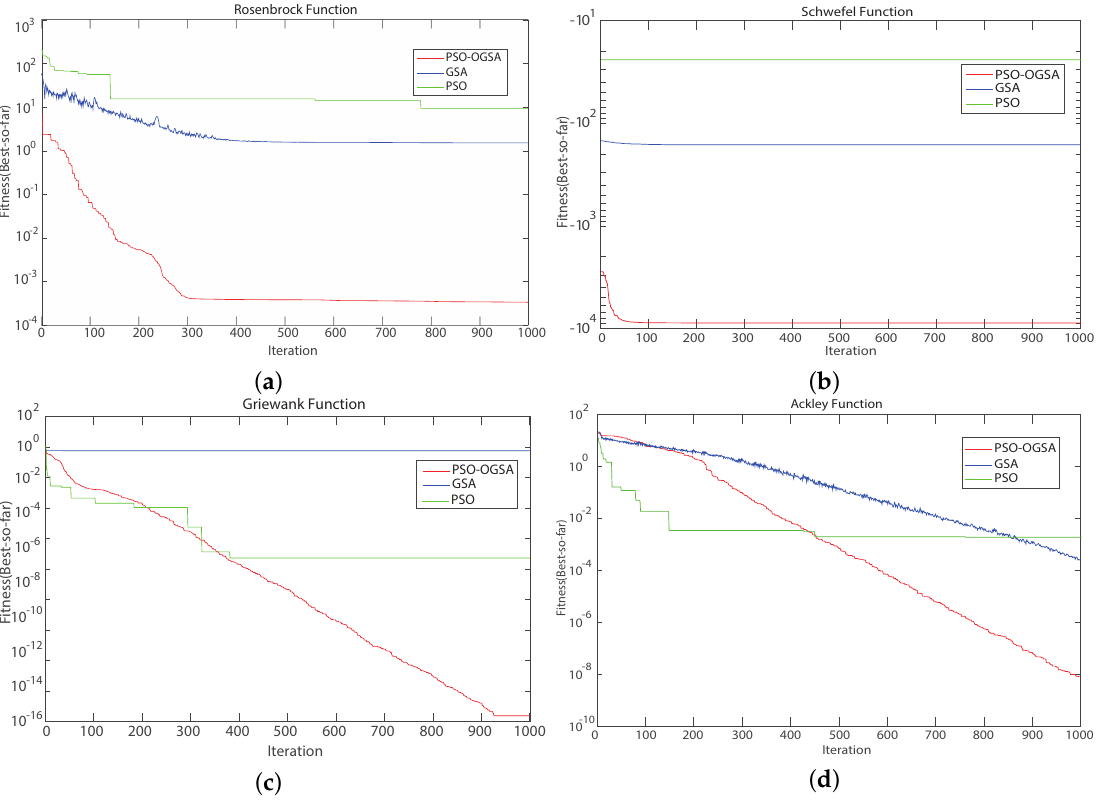
Ave : Indicates average of best function values in 30 runs. Best : Indicates the best result in 30 runs.